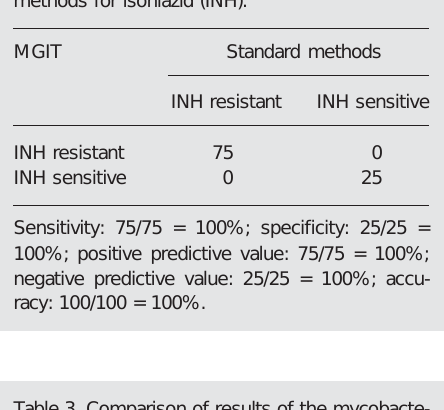
Table 3. Comparison of results of the mycobacte- ria growth indicator tube (MGIT) versus standard methods for rifampicin